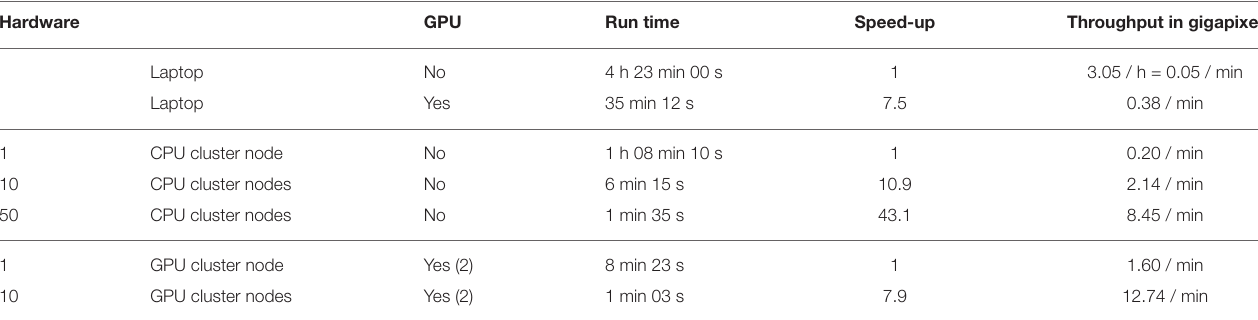
TABLE 1 | Benchmarking computation speed while segmenting a large biological image on various hardware: the experiment was performed on a laptop with and without GPU acceleration, and on different numbers of CPU and GPU cluster nodes.